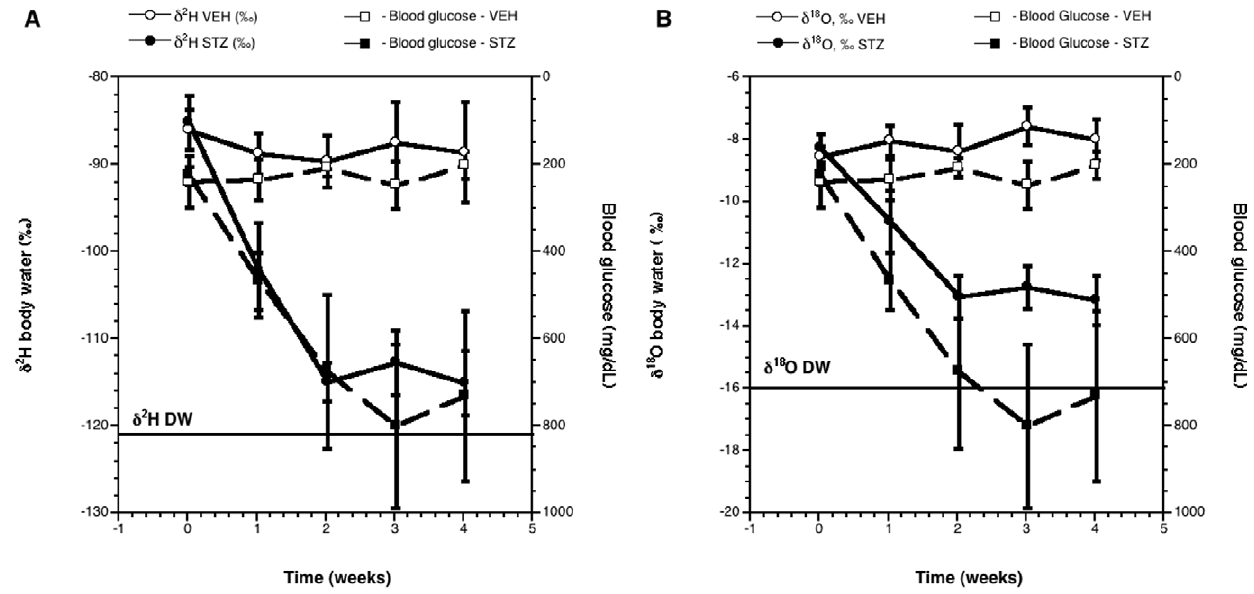
Figure 4. Isotopic values of body water relative to blood glucose. Isotopic signature of body water (y1 axis) and blood glucose values (y2 axis) over the 5 week study period relative to the isotopic signature of drinking water ( 2 DW). Time 0 is prior to STZ treatment. (A) d 2 H of body water and blood glucose values of VEH treated ( # and % , respectively; n=7) and STZ treated ( and blood glucose values of VEH treated ( # and % , respectively ; n=7) and STZ treated ( deviation for duplicate sample analyses.